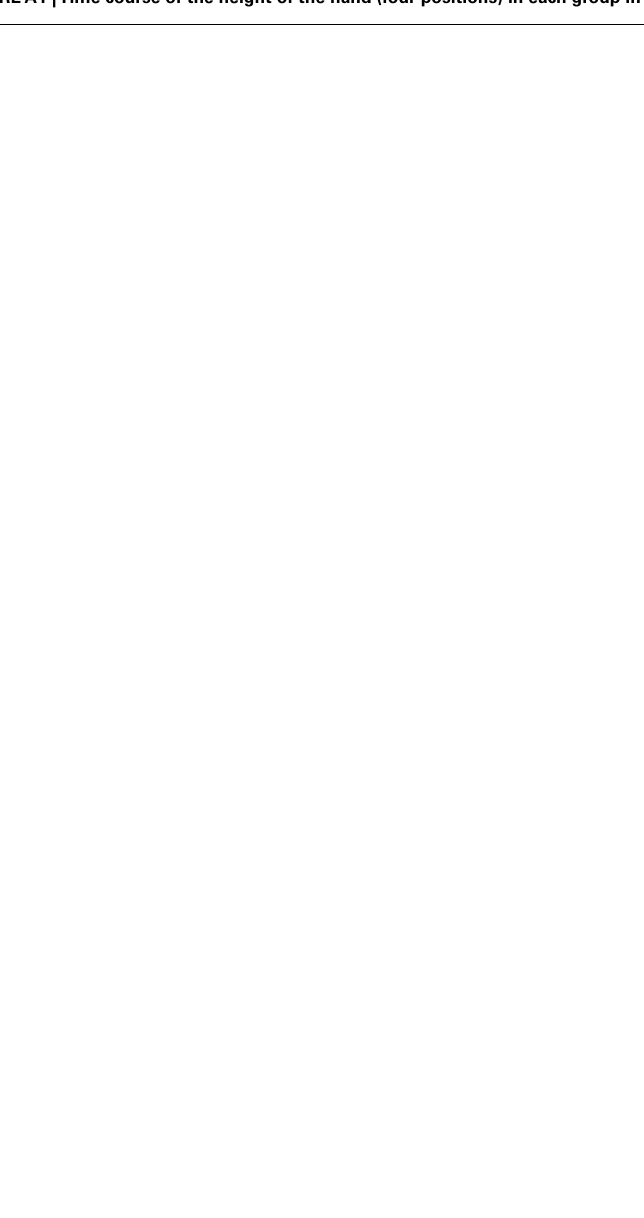
FIGUREA1 |Time course of the height of the hand (four positions) in each group in Experiment